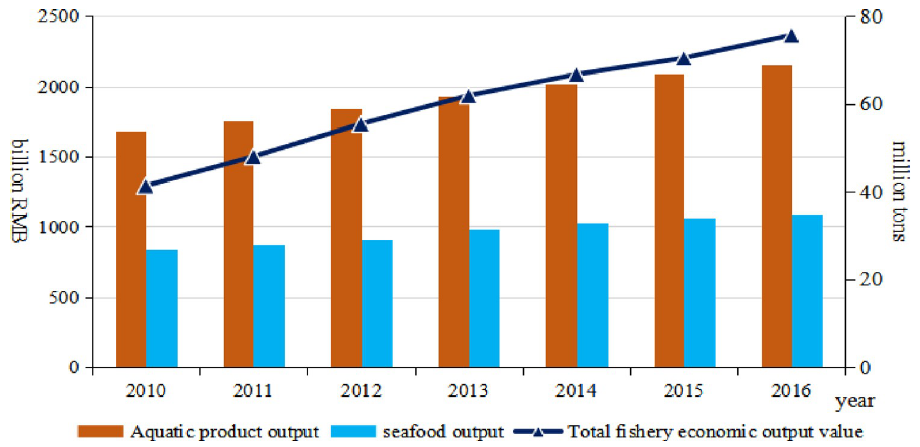
Fig 1. The changes in the total output value of fishery economy and the output of aquatic products in China [2].